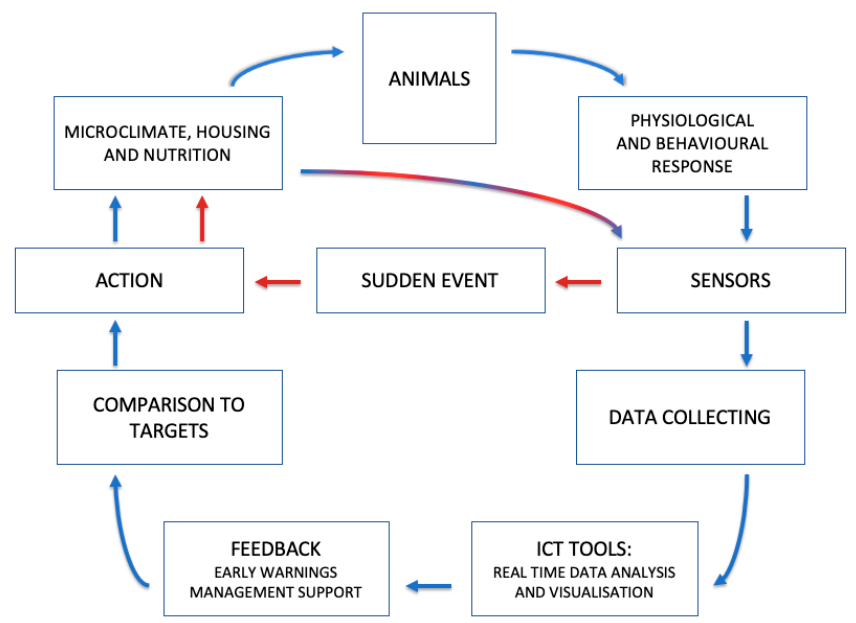
Figure 1. Schematic overview of farm management optimisation through the implementation of PLF tools [18–20]. The sensors are used both to collect data leading to the optimization of daily decisions in farm management and as an element of a direct response to microclimate changes occurring in the livestock building (marked with red arrows), which, in response to the needs, e.g., automatically controlling ventilation by adjusting the velocity in case of elevated temperature or humidity levels [21].